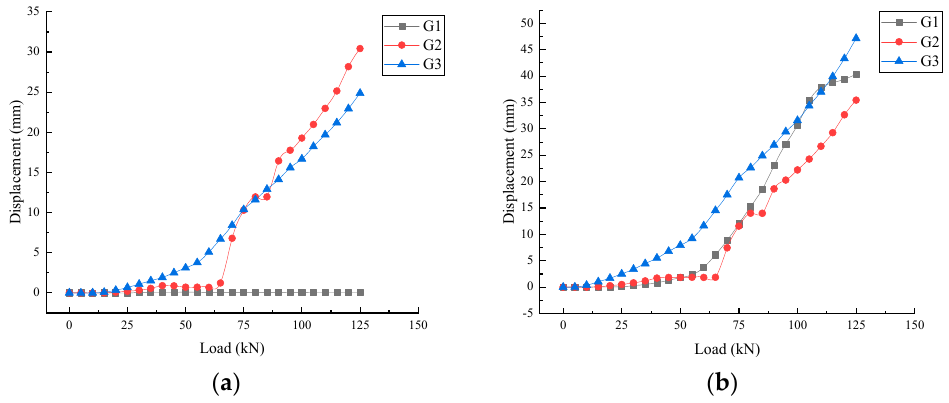
Figure 8. Displacement of representative measurement points in each group of tests. ( a ) Measurement point D4. ( b ) Measurement point D3.